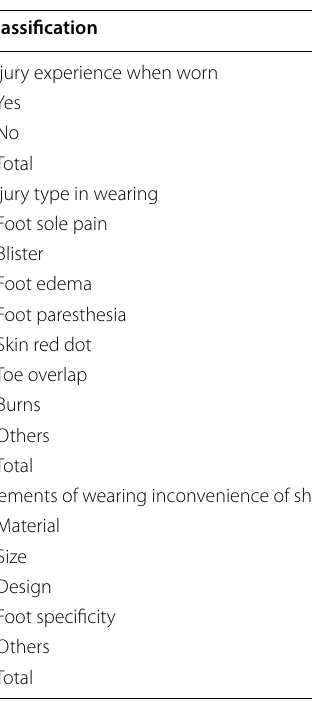
buckles for size improvement and closer contact at the ankles. Instead of the existing black color, yellow, red, and retro-reflective grey were appropriately used. Sample I is the design that won a prize at the Firefighting Industry Excellent Design Competition.